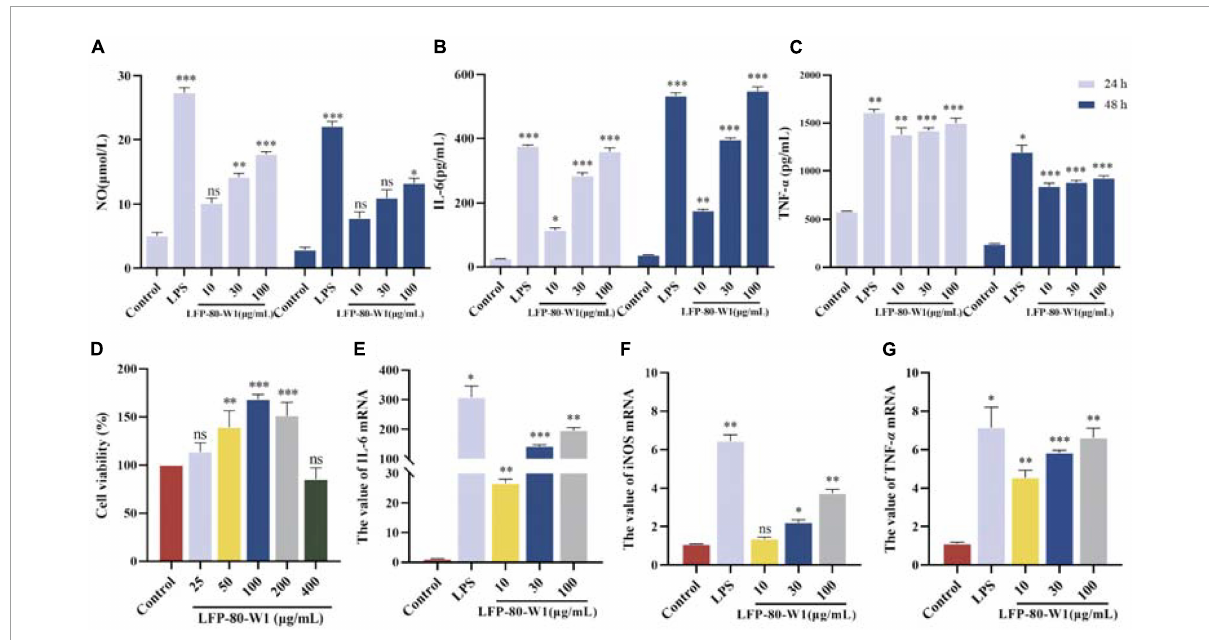
FIGURE6 Identification of LFP-80-W1 as a potent immunopotentiator of RAW 264.7 cells. (A) The amount of NO produced from the LFP-80-W1 treated RAW 264.7 cells for 24 h or 48 h. Lipopolysaccharide (LPS) 1 µ g/mL served as a positive control. (B) TNF- α and (C) IL-6 from RAW 264.7 cells. (D) Effect of LFP-80-W1 on the viability of RAW264.7 cells. The mRNA expression levels of (E) iNOS, (F) IL-6 and (G) TNF- α determined by Real-Time PCR. GAPDH was used as a control. The values are presented as means ± SD ( n = 3). * p < 0.05, ** p < 0.01, and *** p < 0.001 compared with the untreated group.